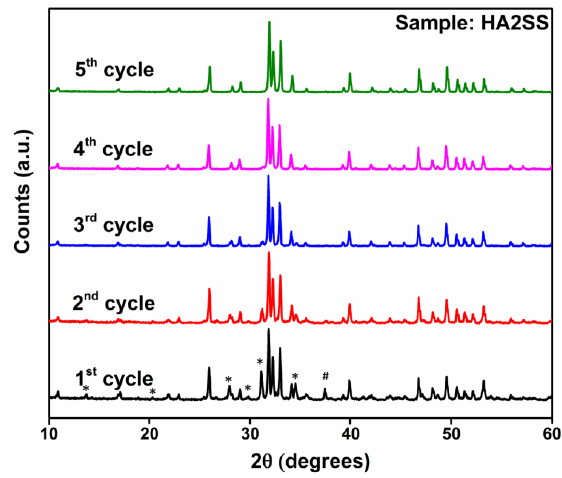
Figure A1. PXRD data showing the phase composition of sample HA2SS after successive sintering/quench cycles. The impurities observed are β -TCP (identified with *) and CaO (identified with #).